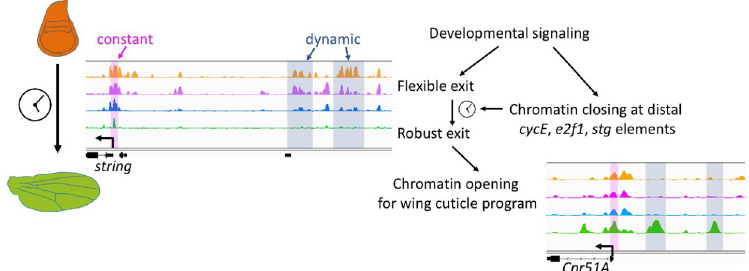
Fig 7. A model for the developmental coordination of cell cycle exit and chromatin accessibility. Potential regulatory elements at complex cell cycle genes such as stg become inaccessible in a developmentally controlled manner during robust G0. This may limit their activation in response to proliferative signals. Delaying or disrupting cell cycle exit impacts the subsequent opening of chromatin at genes in the wing terminal differentiation program that are potentially controlled via transcription factors downstream of ecdysone signaling. Cpr, Cuticular protein; cycE, cyclin E; E2F, E2F transcription factor; stg,